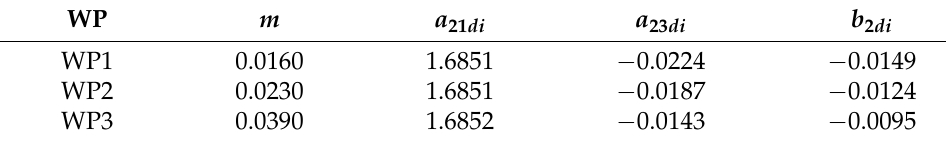
Table 3. Parameters of discrete-time model matrices (31) for 3 working